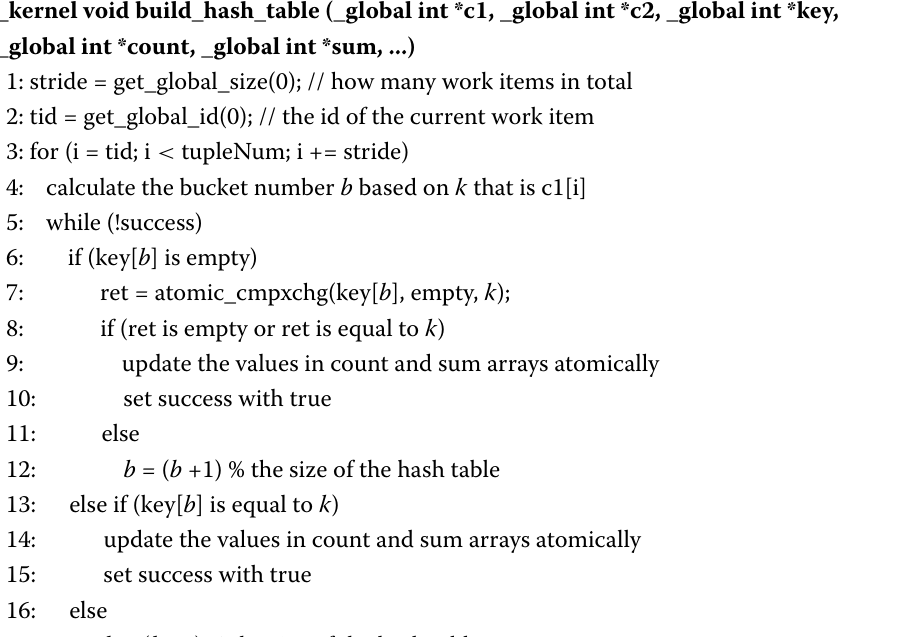
Algorithm 1 The kernel build_hash_table of linear probing with shared hash